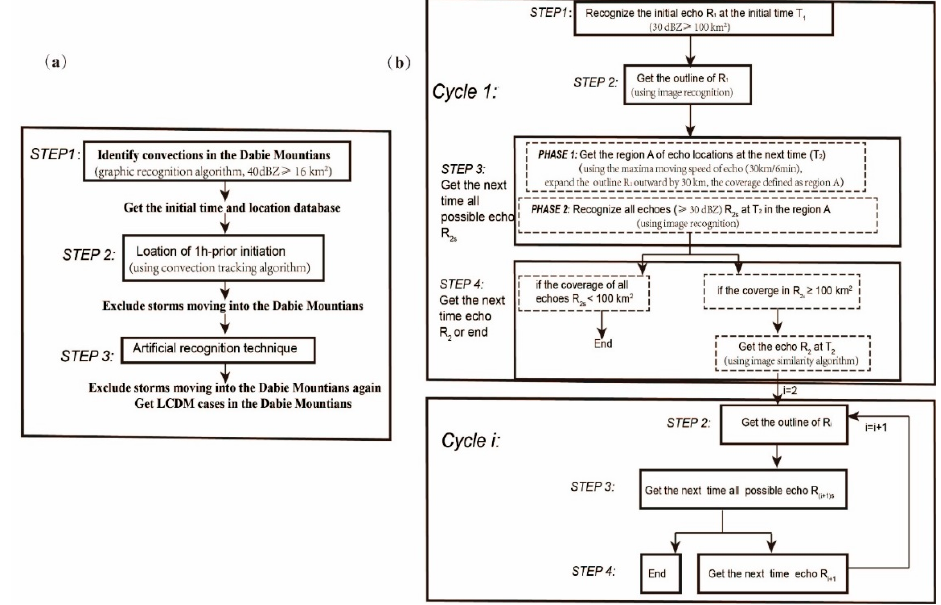
Figure 2. The flow chart of ( a ) the local convection identification algorithm and ( b ) the tracking process of LCDM.